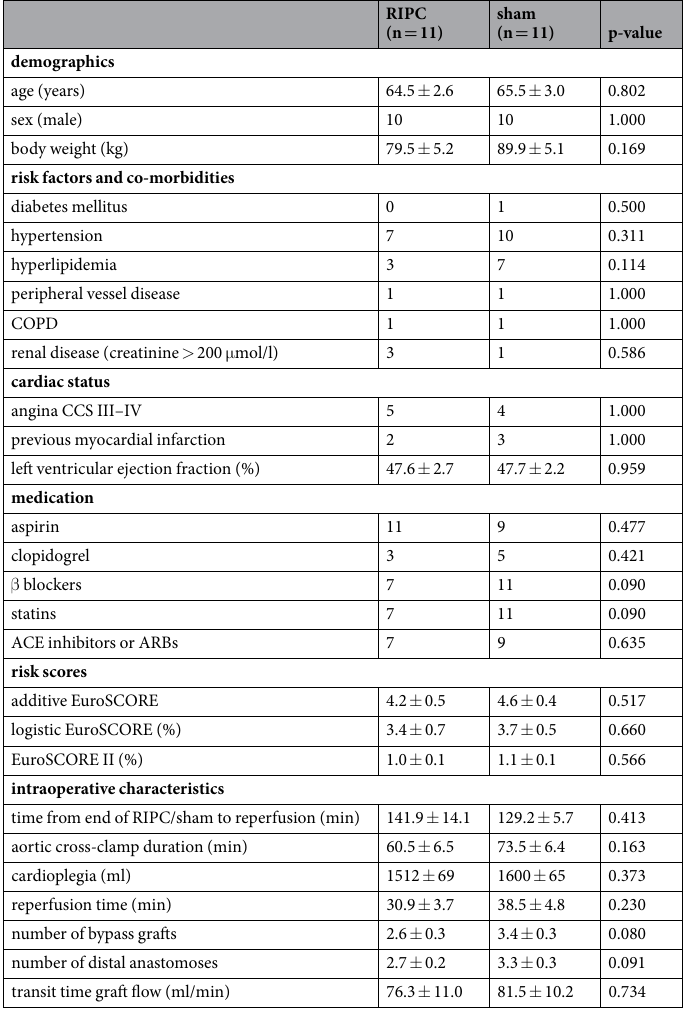
The proteome analysis of porcine LV biopsies taken at baseline and early reperfusion detected 3660 and 3674 proteins after in-solution digestion and 2321 and 2452 phosphorylation sites after phosphopeptide enrichment, respectively. The comparison of the proteome analysis between RIPC and sham revealed 3706 and 3650 proteins after in-solution digestion and 2404 and 2405 phosphorylation sites after phosphopeptide enrichment (Fig. 5, line (a)), respectively. In porcine LV biopsies, there was no FDR-based statistical difference in the protein expression between base- line and early reperfusion or between RIPC and sham, respectively (Supplemental Fig. S5). There was also no dif- ference in the protein phosphorylation at baseline between RIPC and sham (Fig. 6a and Table 2). The FDR-based statistical analysis revealed a higher phosphorylation of 3 proteins at early reperfusion with RIPC than with sham (Fig. 6b and Table 2). In pigs with RIPC, the comparison between baseline and early reperfusion revealed a decrease in 1 and an increase in phosphorylation of 47 proteins from baseline to early reperfusion (Fig. 6c and Table 2). In pigs with sham, the phosphorylation of 42 proteins was decreased and that of 82 proteins increased from baseline to early reperfusion (Fig. 6d and Table 2). Independent of the FDR-based statistical analysis, there was obviously a shift towards a greater number of proteins with increased phosphorylation at early reperfusion with RIPC than with sham (Fig. 6b and c). The FDR-based statistically identified 175 phosphorylation sites which were associated with 116 different proteins, 39 of which were phosphorylation sites of 20 previously uncharacterized proteins (Table 2). There was an overlap of 48 phosphorylation sites of 21 identified proteins at early reperfusion with both, RIPC and sham,